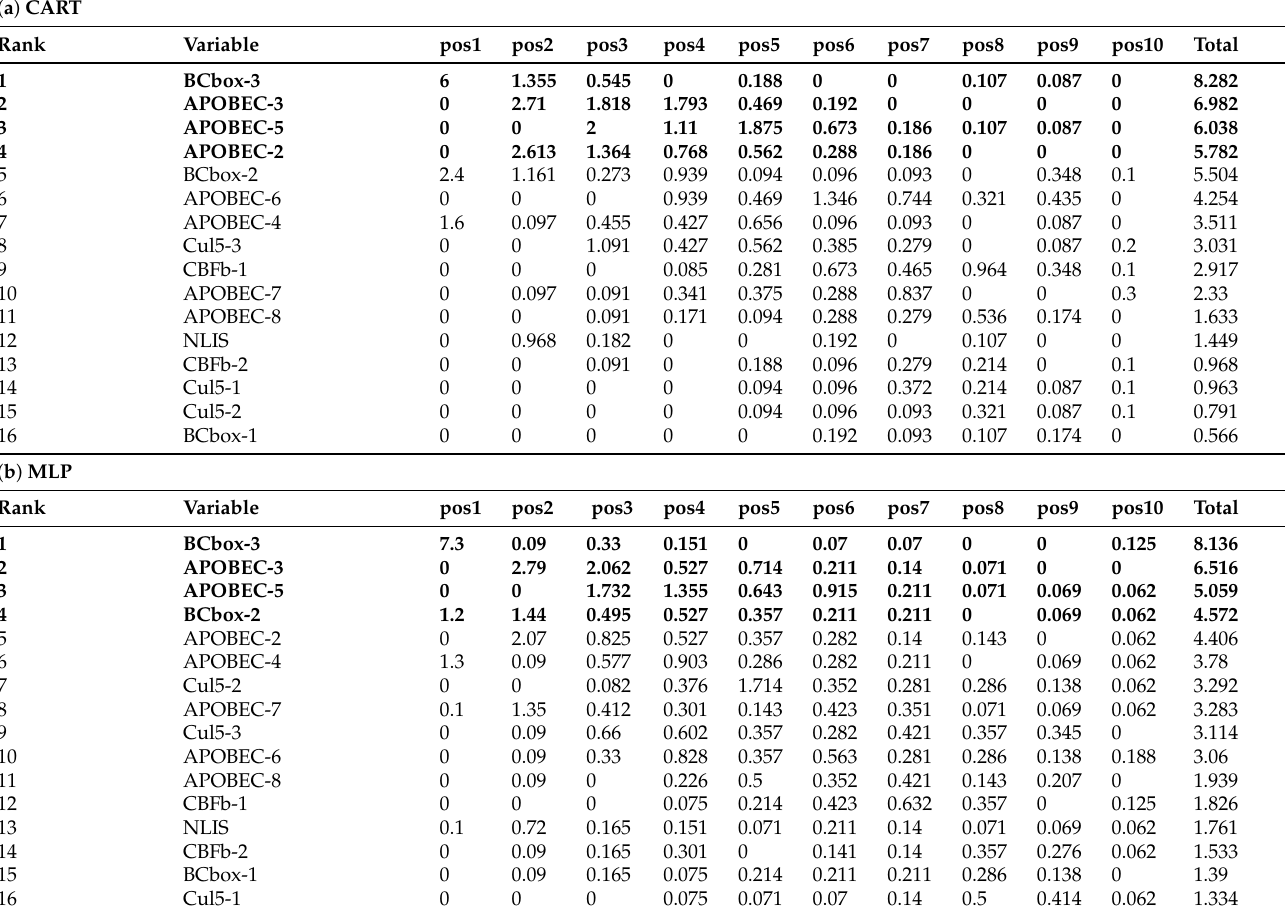
Table A1. Relevance scores ( r ) in a descending order per algorithm and variable considering the clinical endpoint CD4Ini using the MAREV-1 approach. The four variables with higher values are highlighted in